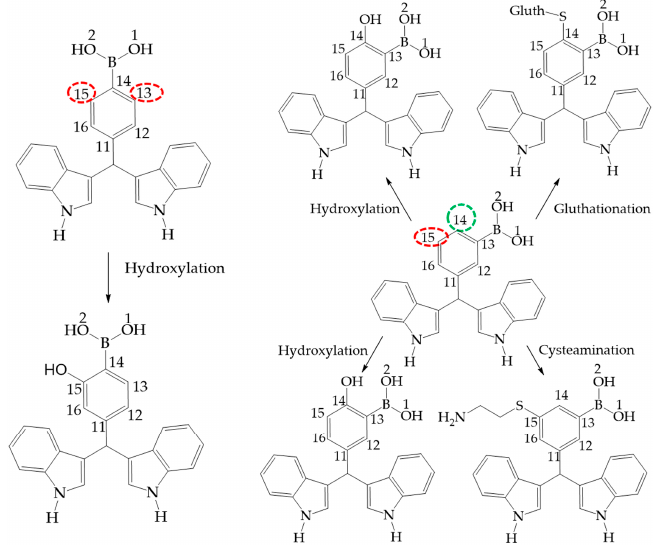
Figure 10. Phase 1 metabolic pathways of III and II . The red color indicates high values of NOR, from 0.66 to 1. The green color indicates a NOR value range of 0.15 to 0.33.